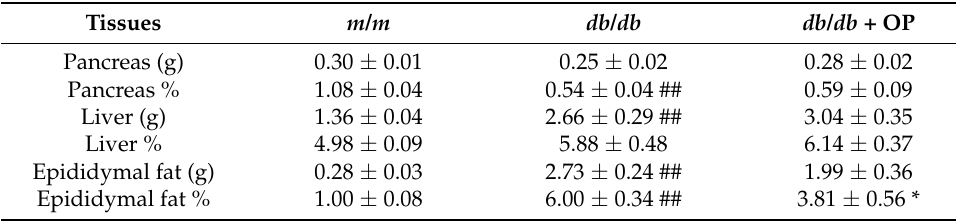
Figure 1. OP alleviated advanced stage of type 2 diabetes in db / db mice. ( a ) Fasting blood glucose levels of db / db group and db / db + OP group mice at week 0, 1, 2, 3, 4, 9, and 15; ( b ) Blood glucose levels during an OGTT and corresponding AUC; ( c ) Levels of blood glucose during an ITT and corresponding AUC; ( d ) Body weight; ( e ) Fasting insulin levels; ( f ) HOMA-IR index; ( g ) Fasting serum GLP-1 levels; ( h ) In db / db mice blood glucose concentrations were determined again 4 h after OP treatment. ## p < 0.01, db / db versus m / m . * p < 0.05, db / db + OP versus db / db ; ** p < 0.01, db / db + OP versus db / db. Table 3. Tissue mass and coefficient of liver, pancreas, and epididymal fat.